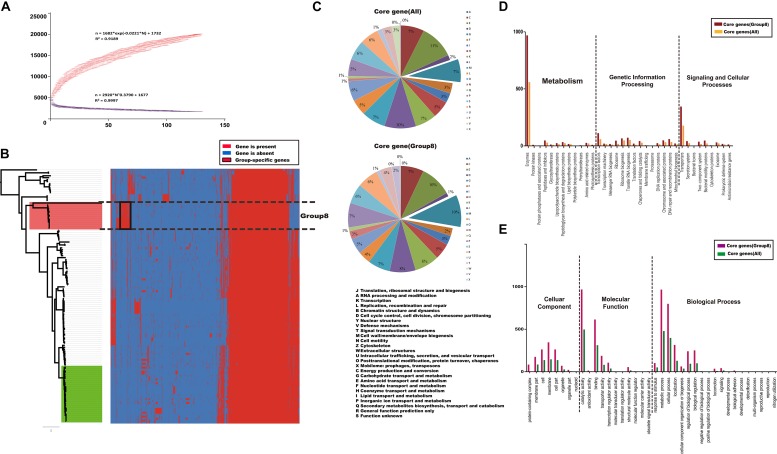
Core and pan-genome analysis of Citrobacter strains. (A) The Citrobacter core and pan-genome plotted were constructed for 129 genome sequences of Citrobacter. (B) Cluster map of the accessory genome of Citrobacter. The gene families that are unique to a species and conserved across most of strains in that species are framed in black. (C–E) Distribution of functional catalogs of core genes of all Citrobacter strains and Group 8 only after COG/GO/KEGG annotation, respectively.